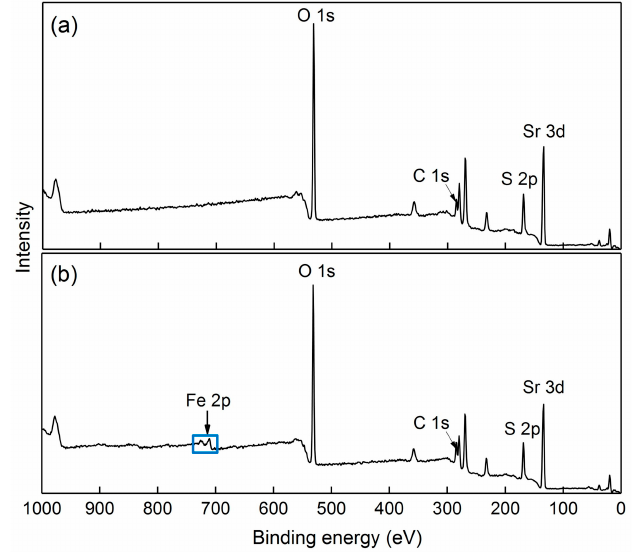
Figure 5. XPS survey spectra of ( a ) untreated celestite and ( b ) celestite treated with ferric ions.